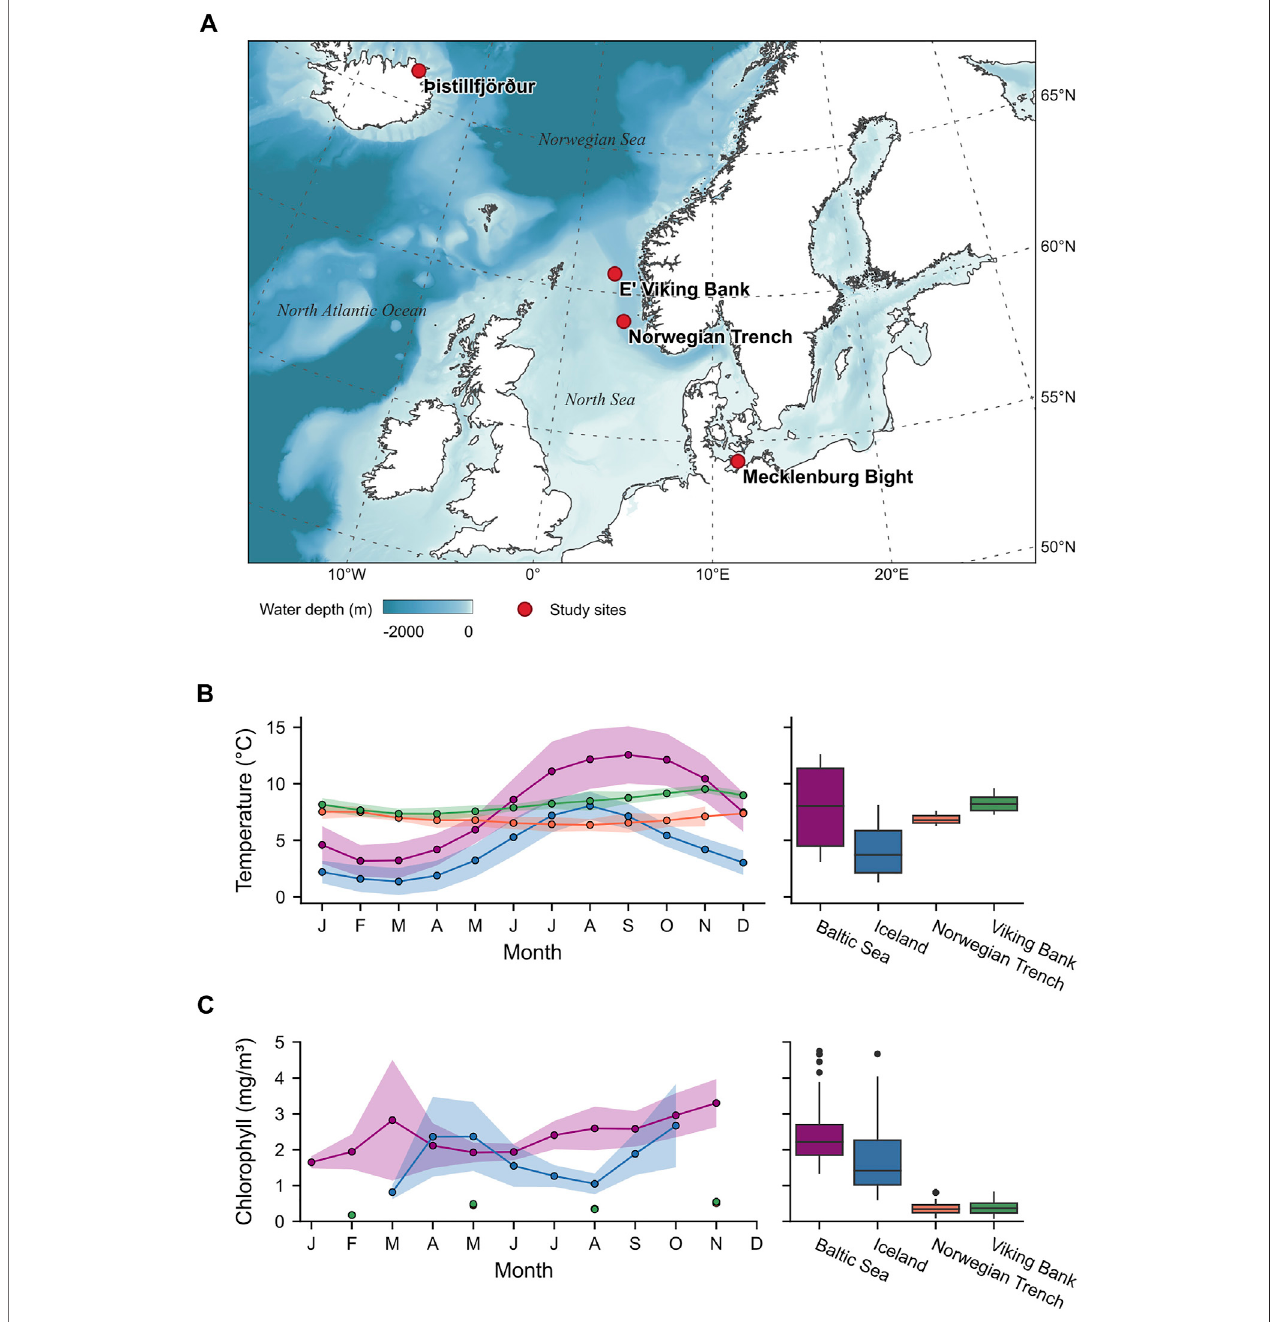
FIGURE 2 | Shell ( Arctica islandica ) collection sites, temperature, and chlorophyll a data. (A) Map of Northern Europe showing the four shell collection sites of this study. Continent contours were taken from NaturalEarth (https://www.naturalearthdata.com/; last access 6 Jul 2021) and bathymetric data were acquired from EMODNet(http://www.emodnet-bathymetry.eu;lastaccess6Jul2021).Notethatdepthsgreaterthan2000 maredisplayedinthesamecolor. (B) Watertemperatures and (C) chlorophyll a concentrations shown as monthly averages (left side; solid line: mean; shaded area: ± one standard deviation) and annual ranges (right side) for each of the localities.